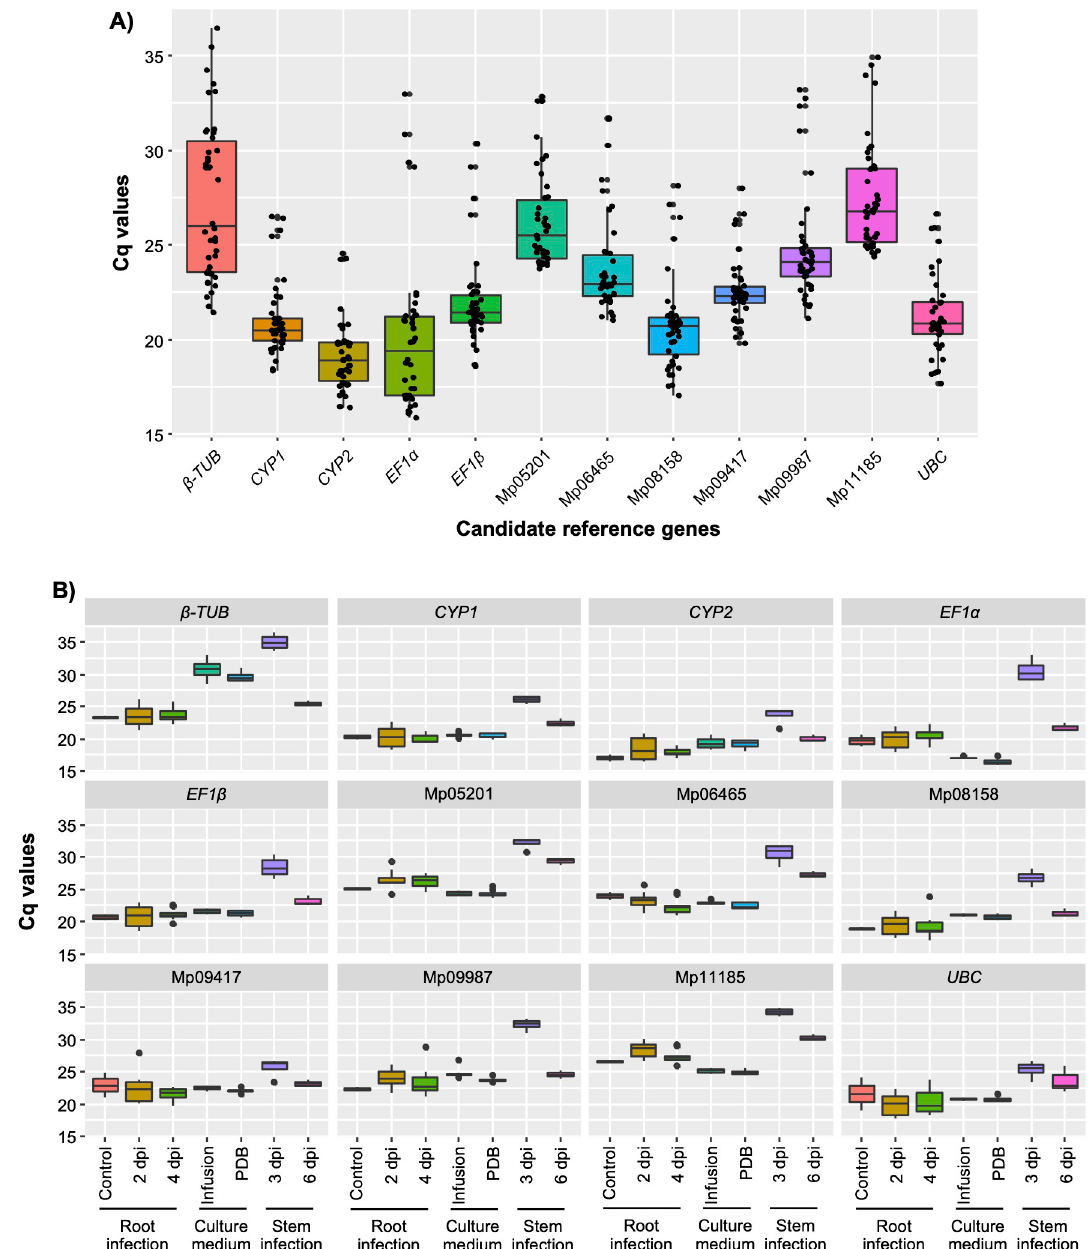
Fig 1. The Cq values of 12 candidate reference genes of M . phaseolina under three procedures. Box plot of the Cq values of (A) all samples, and (B) each treatment group. Box indicates the 25 th and 75 th percentiles, the central horizontal line across the box represents the median of the samples. The bars indicate the maximum and minimum